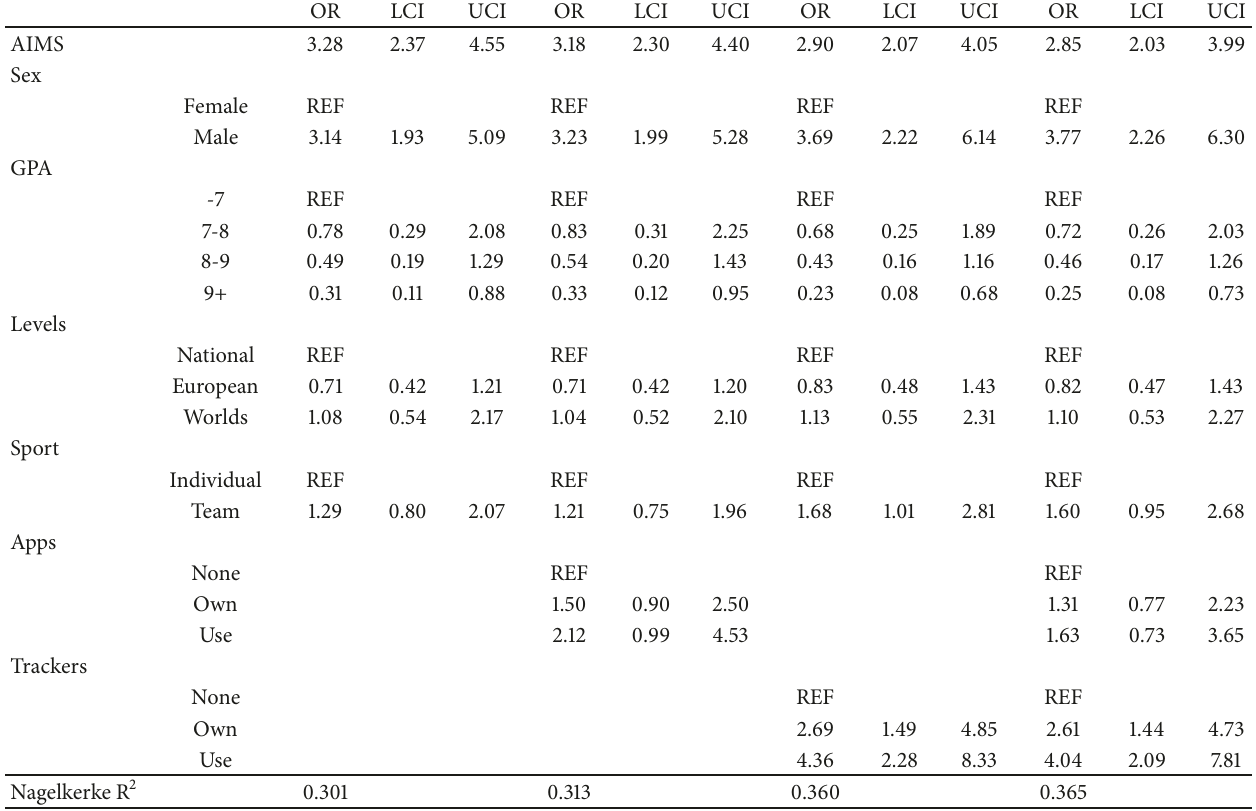
Table 3: Binary logistic regressions of sport aspiration with phone apps and fitness